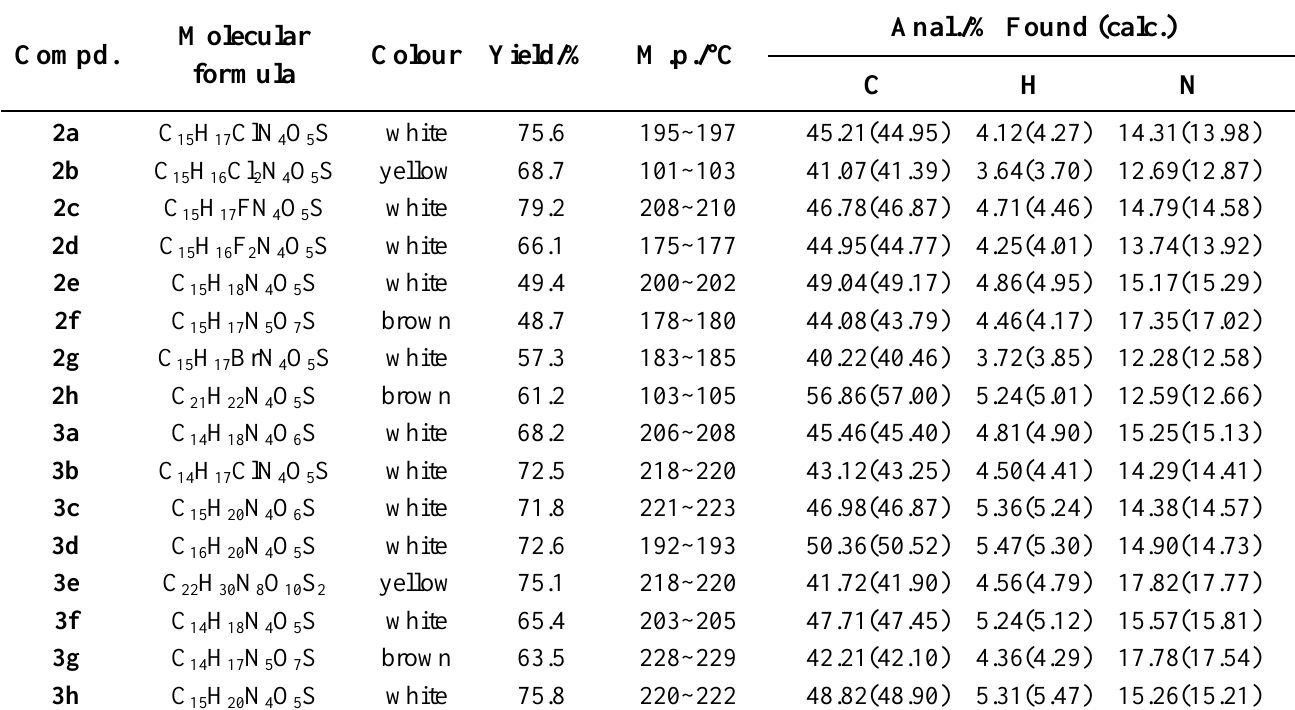
Table 2 . Physical data of compounds 2a ~ 2h , 3a ~ 3h .